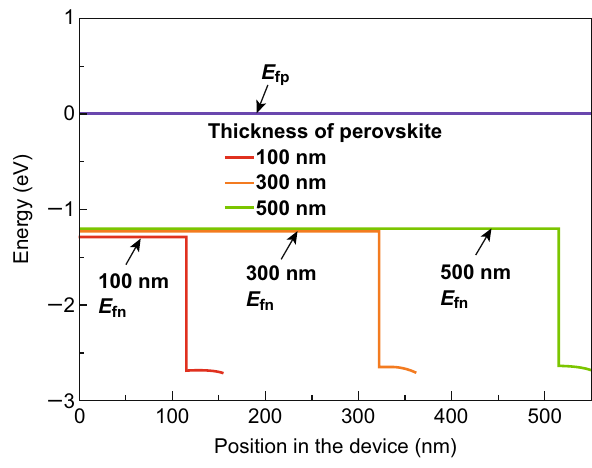
Fig. 3 Quasi-Fermi level with different perovskite layer thicknesses